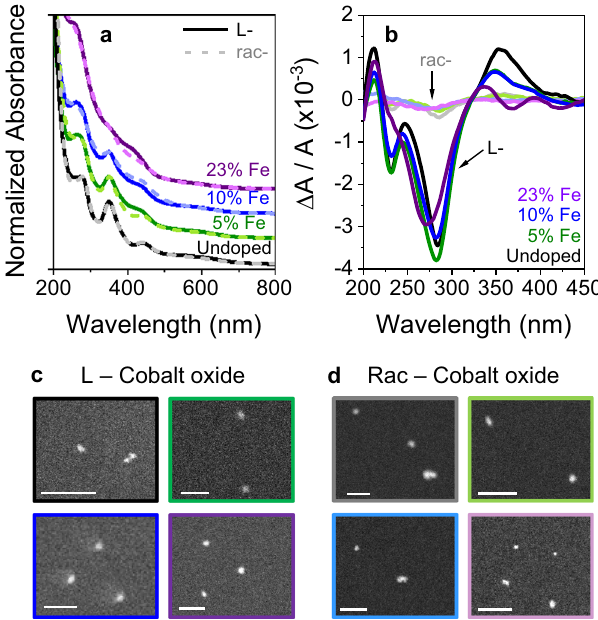
Fig. 1 | Characterization of catalysts. Absorbance ( a ) and circular dichroism ( b ) spectraofundoped(black)and5%(green),10%(blue),and23%(purple)iron-doped Rac- (light, dashed line) and L-cobalt oxide (dark, solid line) nanoparticles. Note that the spectra in ( a ) are displaced from each other for clarity. c , d Show repre- sentative STEM images of the catalysts for L-cobalt oxide and Rac-cobalt oxide respectively.Thecoloroftheborderre fl ectsthesamecolorcodingasusedin( a , b ) and the scale bar in the images is 25nm.